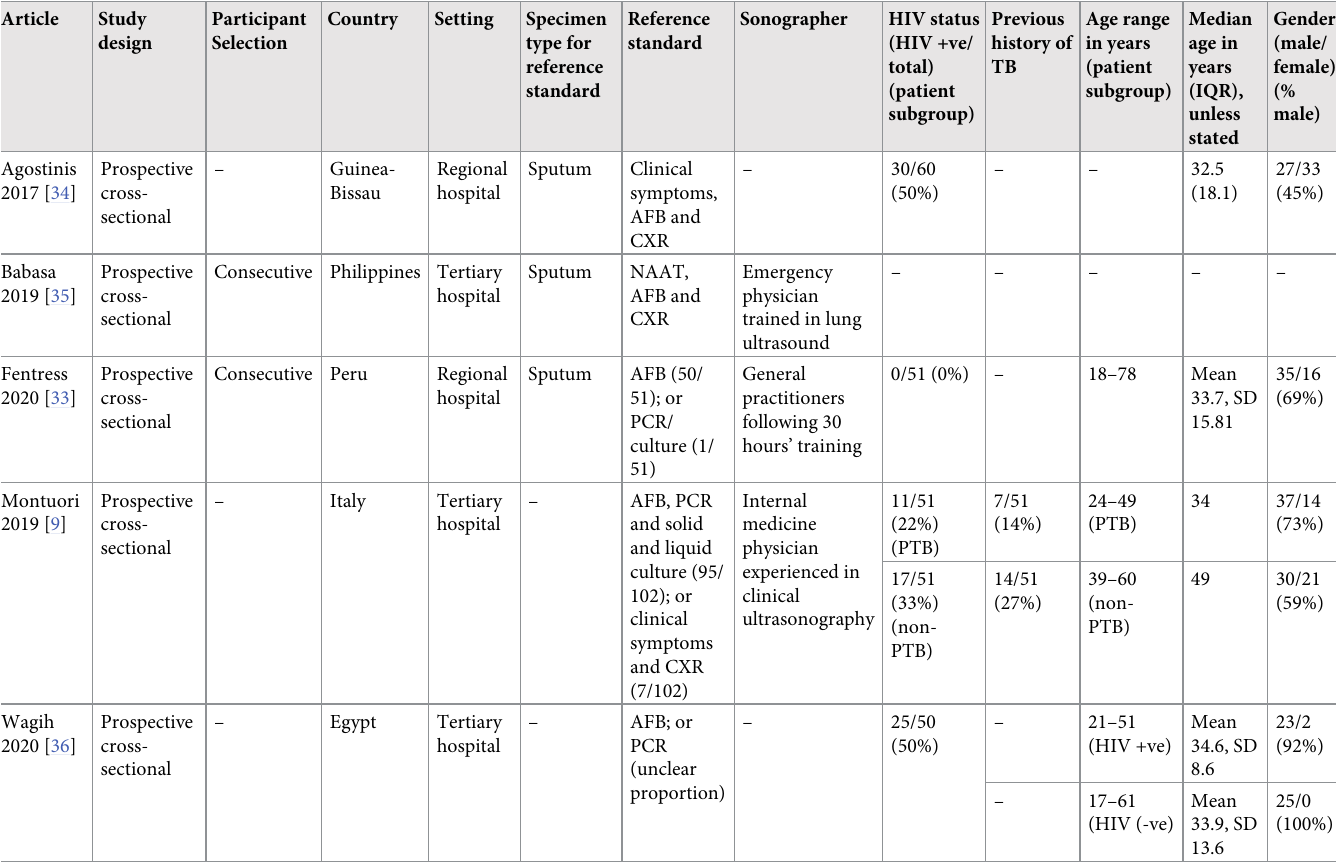
Table 1. Individual study characteristics for studies in